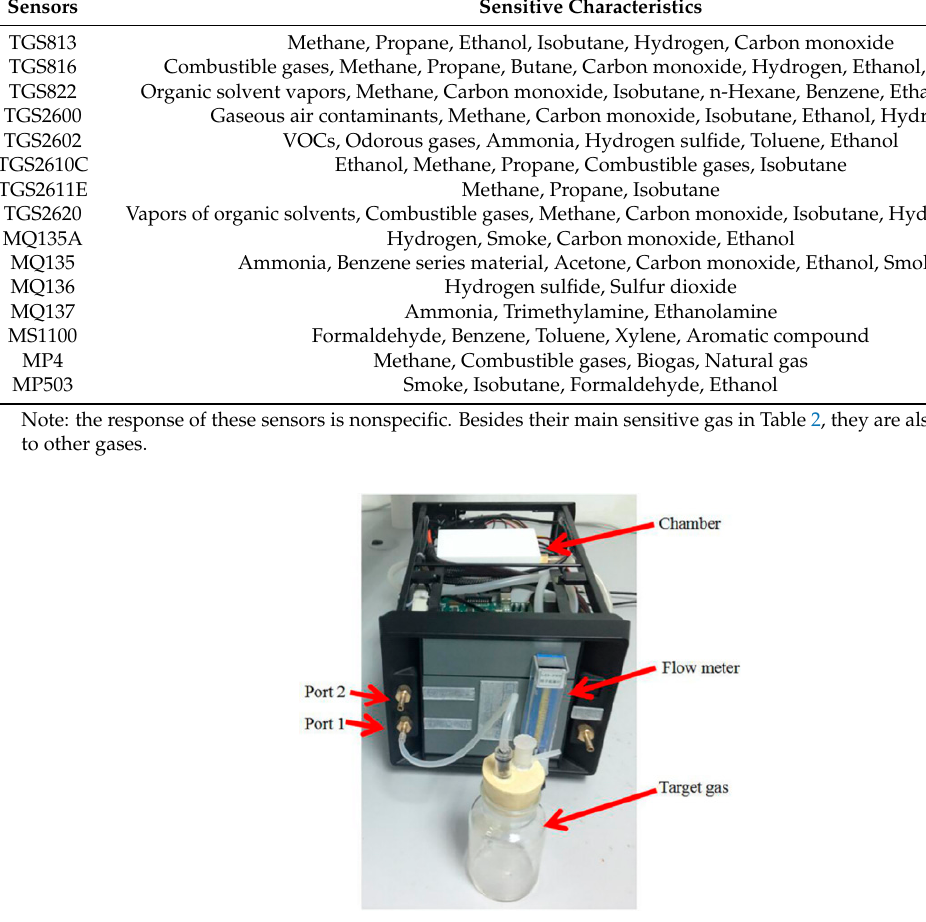
Figure 3. A practical E-nose system.